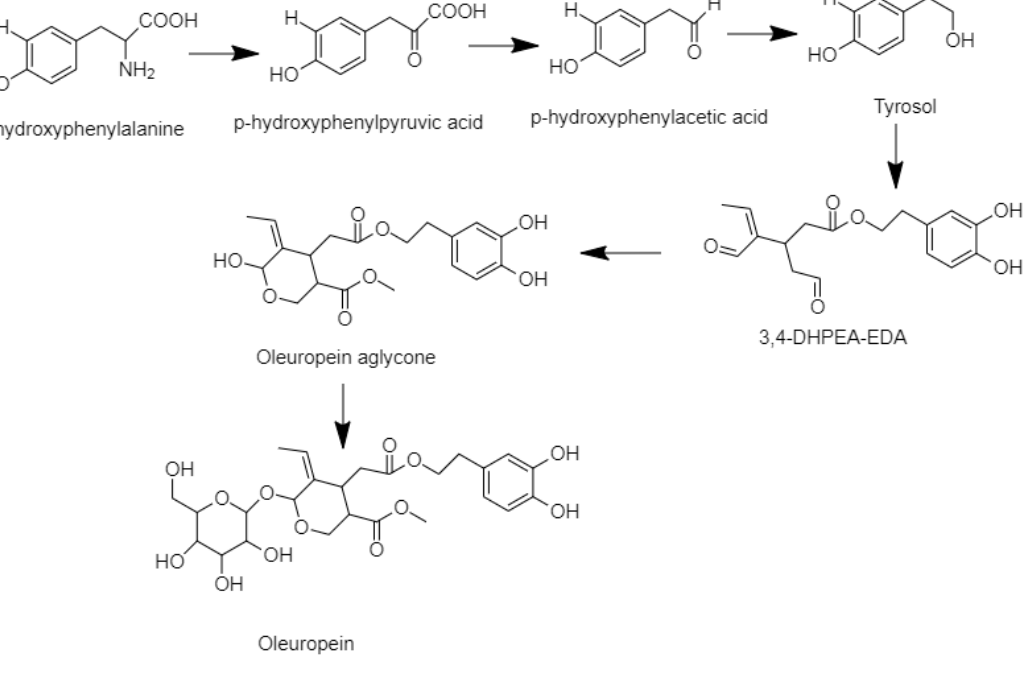
Figure 2. Oleuropein biosynthesis [33].